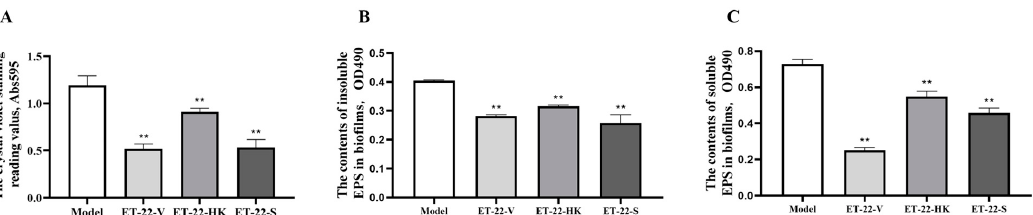
Figure 1. Effects of L. paracasei ET-22 on formation of S. mutans biofilms. ( A ). The effects of live bacteria (ET-22-V), heat-killed bacteria (ET-22-HK), and secretions (ET-22-S) of L. paracasei ET-22 on the formation levels of S. mutans biofilms. The single pathogen S. mutans (Model) was cultured as a control. Means ± SEM are shown ( n = 6). ** p < 0.01, vs . Model group. ( B ). The effects of live bacteria, heat-killed bacteria, and secretions of L. paracasei ET-22 on the contents of insoluble extracellular polysaccharides (EPS) in S. mutans biofilms. Means ± SEM are shown ( n = 6). ** p < 0.01, vs . Model group. ( C ). The effects of live bacteria, heat-killed bacteria, and secretions of L. paracasei ET-22 on the contents of soluble EPS in S. mutans biofilms. Means ± SEM are shown ( n = 6). ** p < 0.01, vs. Model group.